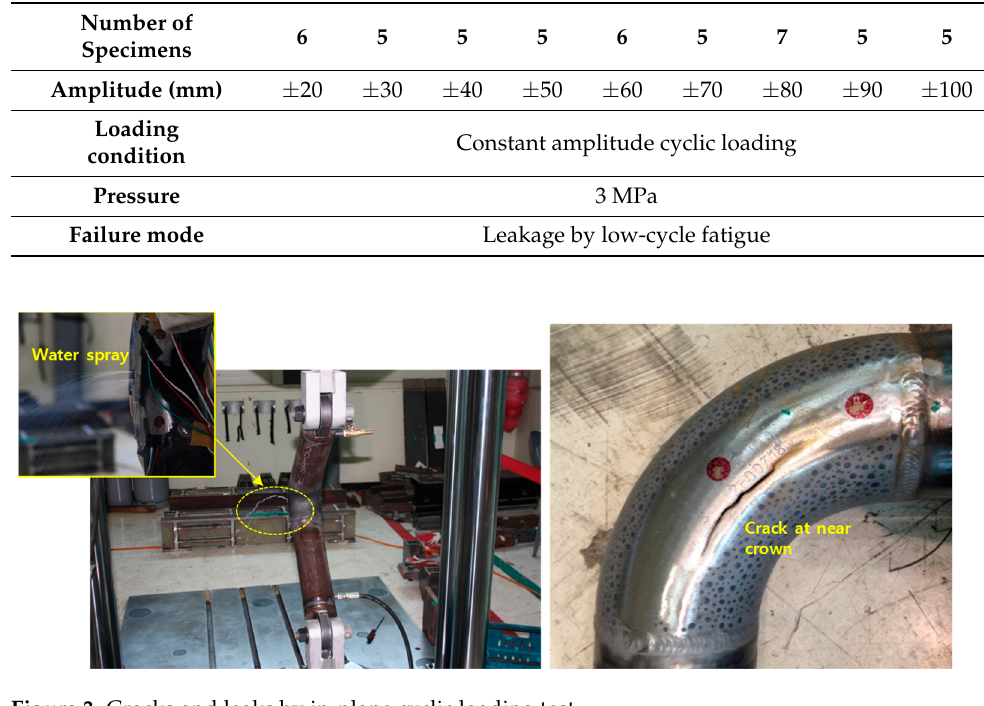
Figure 3. Cracks and leaks by in-plane cyclic loading test. Table 2. Results of the pipe element test.